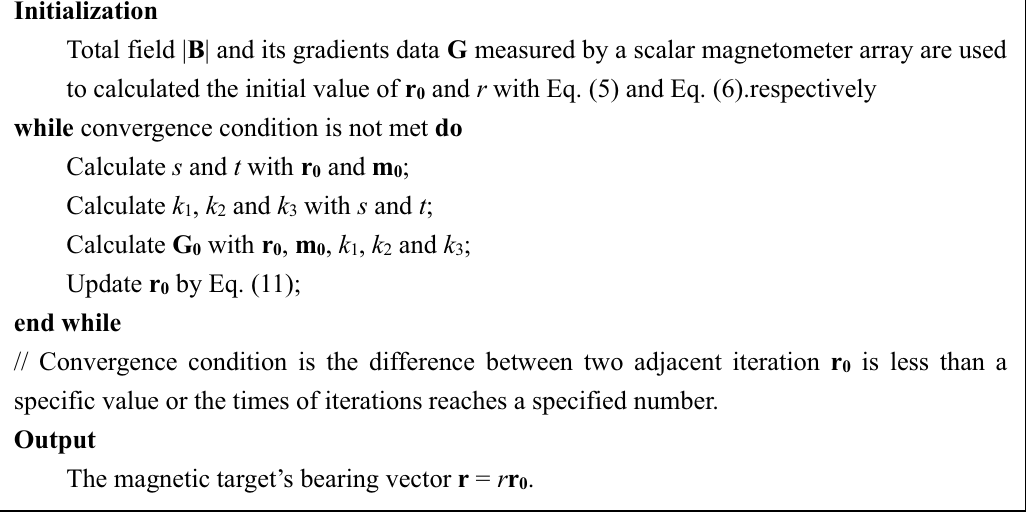
Table 1. The pseudocode of the iteration algorithm.